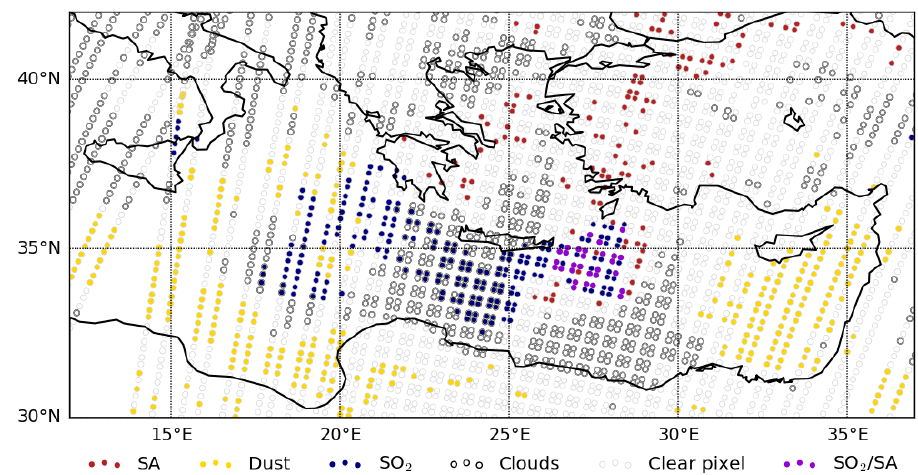
Figure 6. Detections of SA (from AEROIASI-H2SO4, in red), SO 2 (from IASI-Oxford, in blue) and dust (from AEROIASI-Dust, in yellow). Simultaneous detections of SA and SO 2 are shown in violet. Cloudy (CF > 20%) and clear-sky pixels (CF < 20%) are indicated with black and light grey contour,